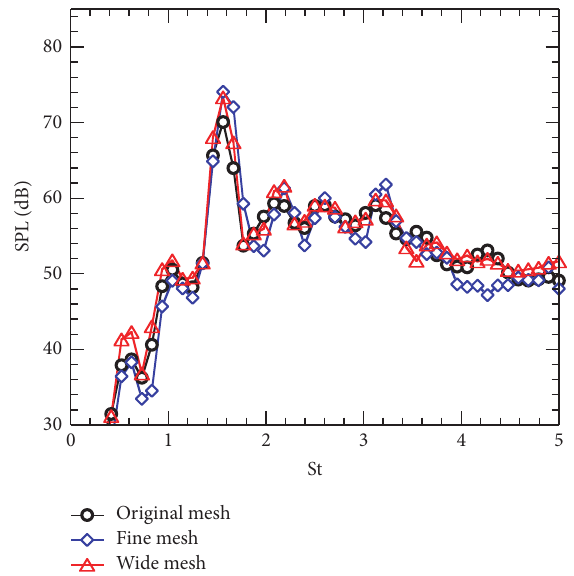
Figure 12: Comparison of predicted sound pressure spectra ( 𝑥/𝐿 = 6.75 and 𝑦/𝐿 = 23.5) with original, finer, and wider meshes for cavity flow without freestream turbulence ( 𝐷/𝐿 =